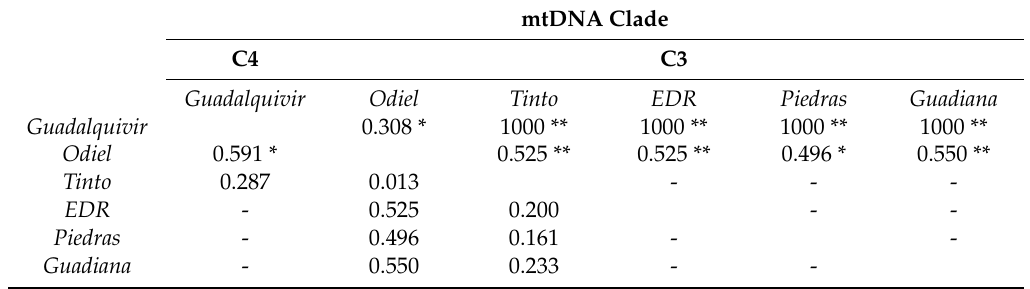
Table 3. Karyotypic di ff erentiation among pairs of populations. F ST values are shown for A-chromosomal number (above the diagonal) and B-chromosome (below the diagonal). Asterisks indicate the significance of exact G tests (* p < 0.01; ** p < 0.001). Pairwise comparisons indicated by “-” could not be estimated due to lack of variation in the pair. mtDNA Clade C4 C3 Guadalquivir Odiel Tinto EDR Piedras 0.308